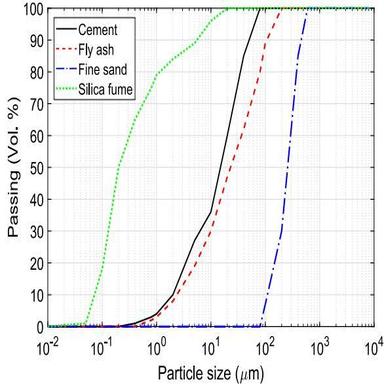
Particle size distribution of materials used.